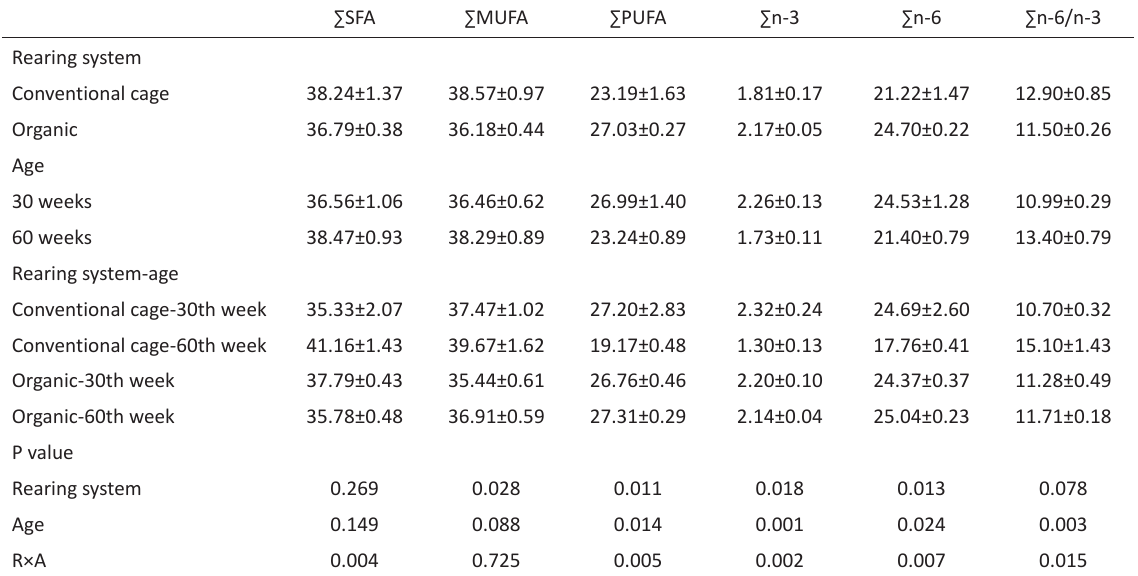
Table 7. Total SFA, MUFA, PUFA, n-3, n-6, n-6/n-3 in the egg yolks (%)